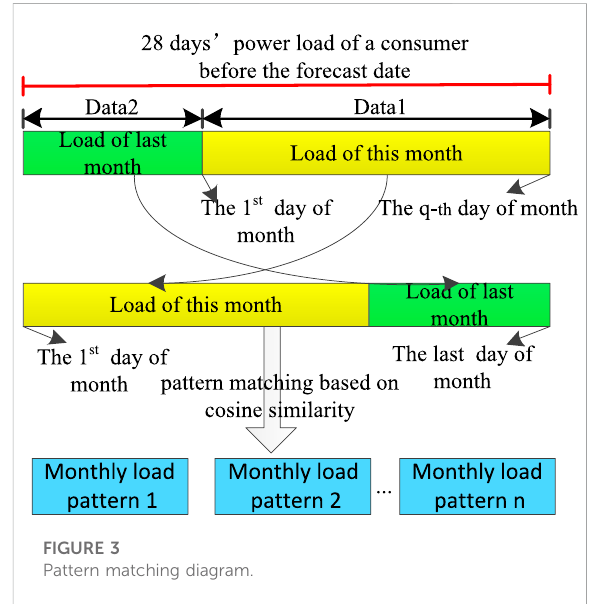
FIGURE 3 Pattern matching